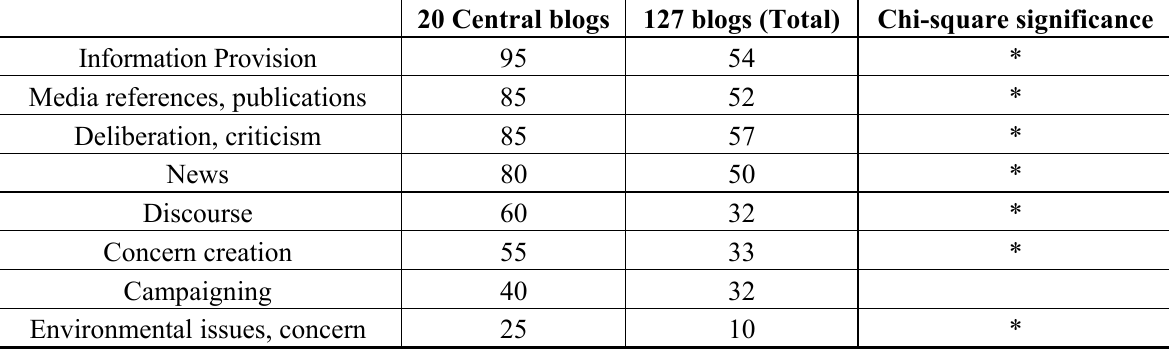
Table 8. Percentages of central blogs, which make references to the eParticipation